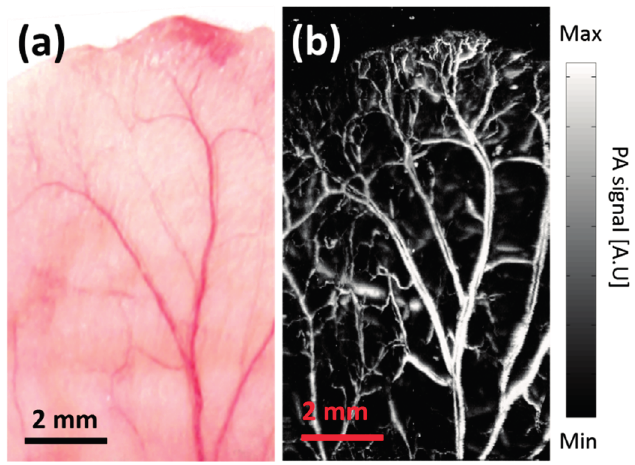
Figure 7. In vivo noninvasive PA imaging of the microvasculatures in a mouse ear. ( a ) Photograph of the mouse ear; ( b ) In vivo corresponding noninvasive PA image of the mouse